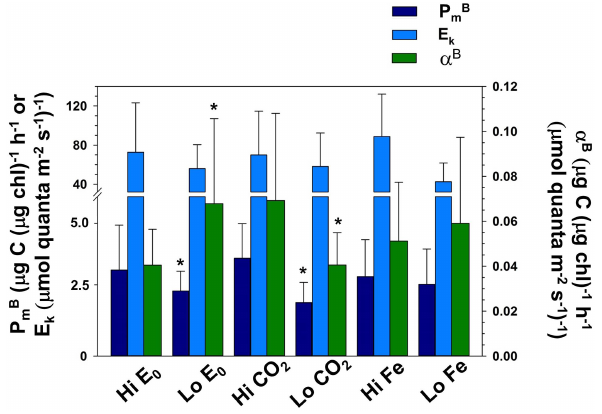
Figure 2. Photosynthesis–irradiance parameters determined from experimental manipulations of natural populations. Samples had high or low (33 or 7% of surface value) irradiance, high or low (750 or 380ppm) CO 2 , and high or low ( + 1nM and ambient; ca. 0.1nm) iron concentrations. Asterisks indicate a significant dif- ference between the high and low treatments within each variable ( ∗ : p <0.05).